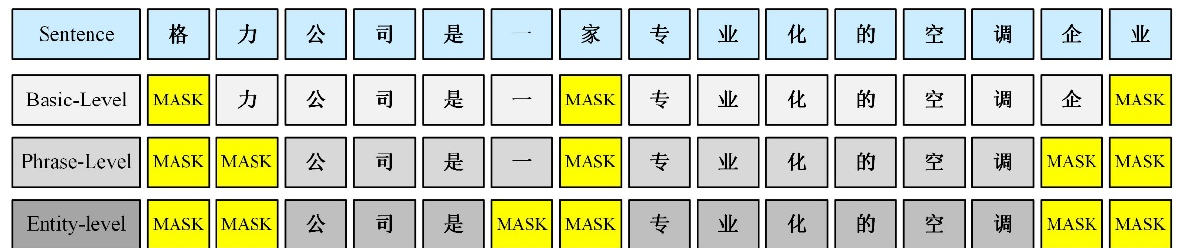
Figure 3. Different mask levels of ERNIE in Chinese sentence.